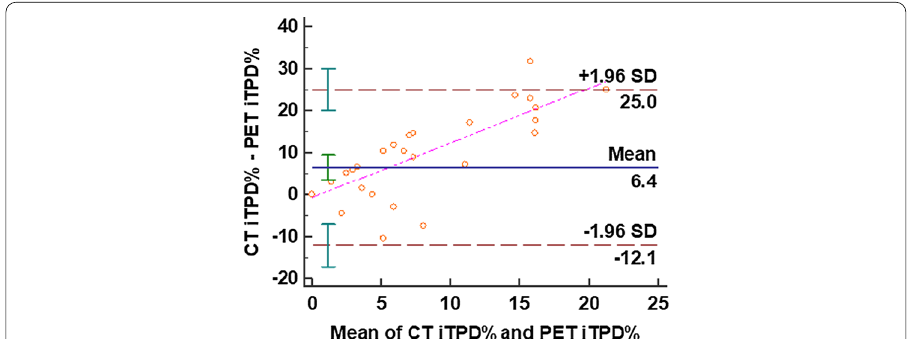
SSS, SRS, SDS, TPDs, TPDr, iTPD are expressed as average % CT-MPI computed tomography myocardial perfusion imaging; Rb-PET Rubidium-positron emission tomography myocardial perfusion imaging